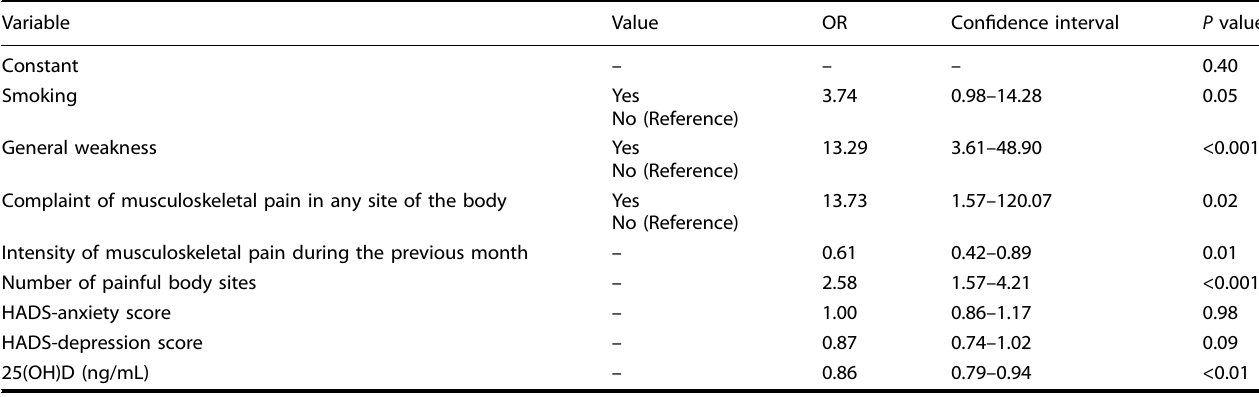
Table 2. Association between asthma and study